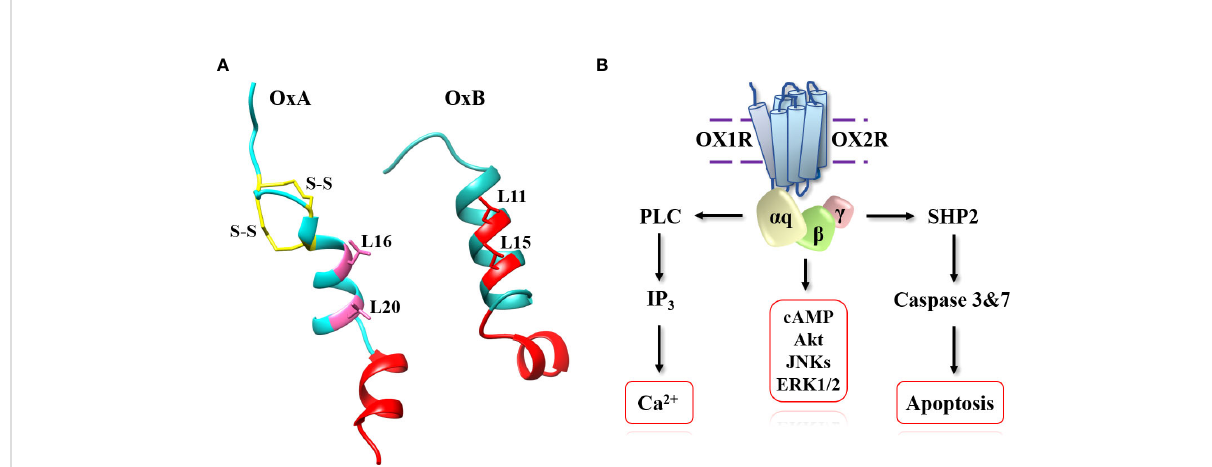
FIGURE 2 OxA and OxB structures (A) and schematic representation of signaling pathways activated by orexins. (A) (left): OxA structure (light blue), disul fi de bridges (yellow), crucial domain involved in OxA activity (red) and putative leucine residues involved in OxA activity (pink). Panel A (right): OxB structure (light sea green) and crucial domain and important leucine residues involved in OxB activity (red). (B) : phospholipase C (PLC), inositol-1,4,5-trisphosphate (IP 3 ), protein kinase B (Akt), c-JUN N-terminal kinases (JNK), extracellular signal-regulated kinases (Erk1/2) and tyrosine-protein phosphatase non-receptor type 11